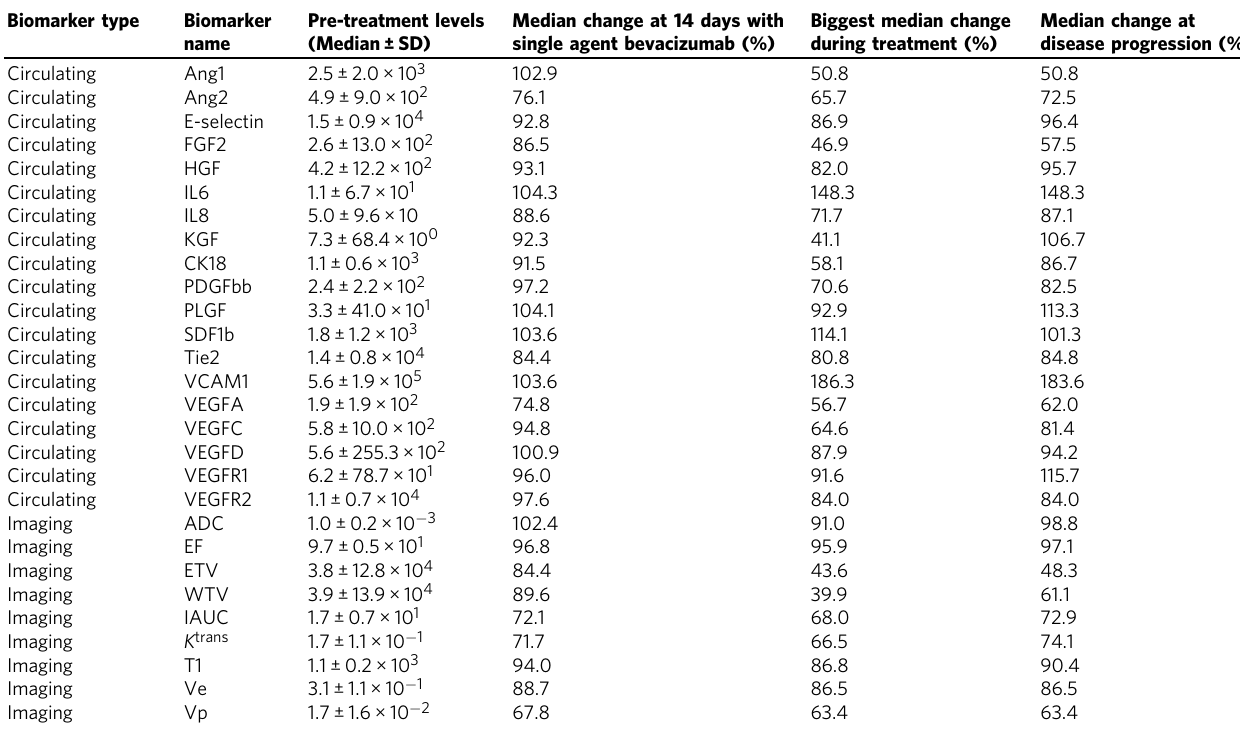
Median pre-treatment levels of circulating and imaging biomarkers are shown, with the standard deviation (SD). Changes through treatment at three time-points are shown, related as a relative percentage (%) to the pre-treatment baseline levels. Values above 100 indicate increased biomarker levels while values below 100 indicate reduced biomarker levels. Plots of biomarker changes are shown in Supplementary Figure 2 The units for circulating biomarkers are pg/ml. The units of ADC are mm2/s; ETV and WTV mm3; IAUC s.mmol/l; Ktrans 1/min; T1 ms. EF, Ve and Vp are all ratios and therefore are unit-less,± indicates plus and minus around one standard deviation